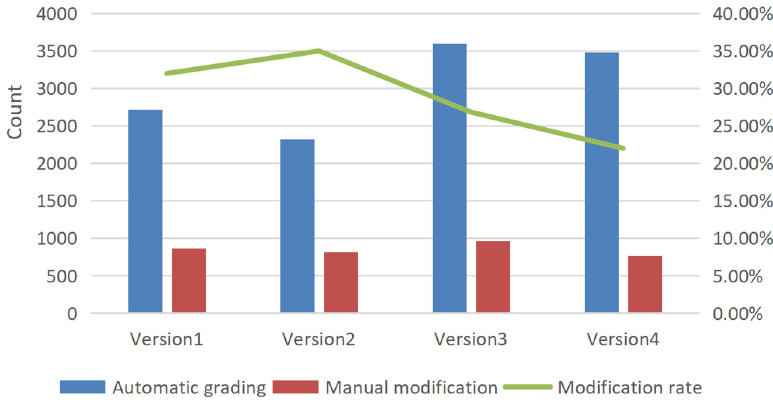
Figure 5. Grading and